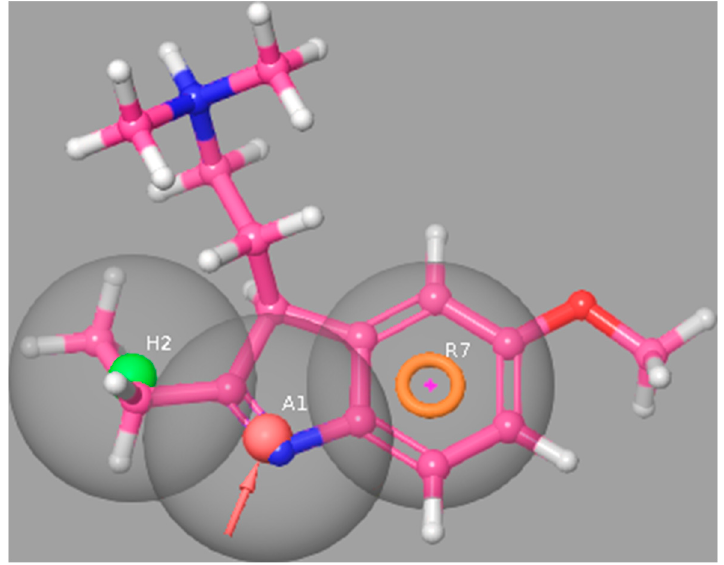
Figure 3. 5-HT 6 R ligand (CHEMBL267615, K i = 16 nM) mapped to the pharmacophore model of the 5-HT 6 R